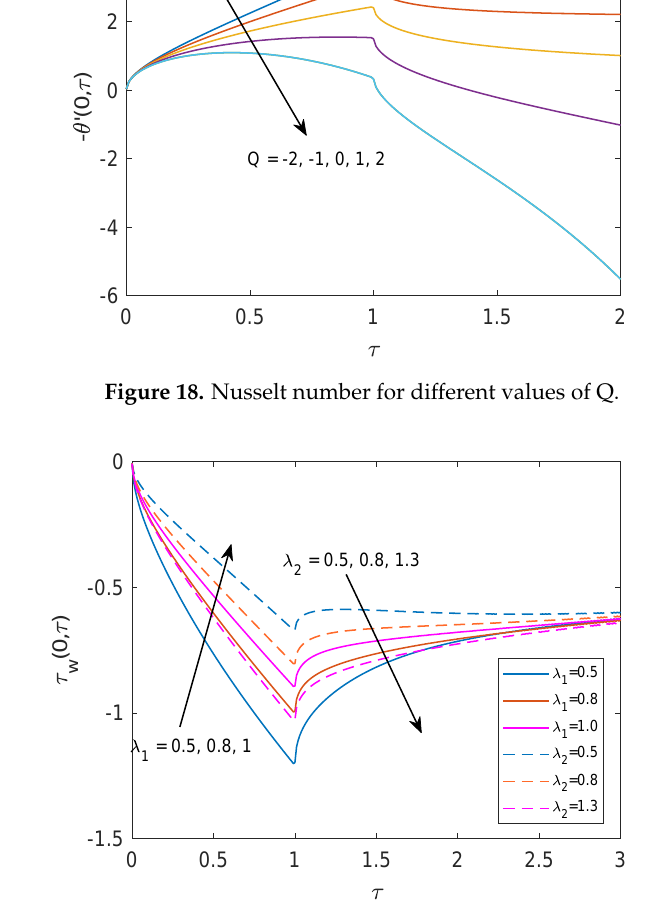
Figure 19. Skin friction for different values of λ 1 and λ 2